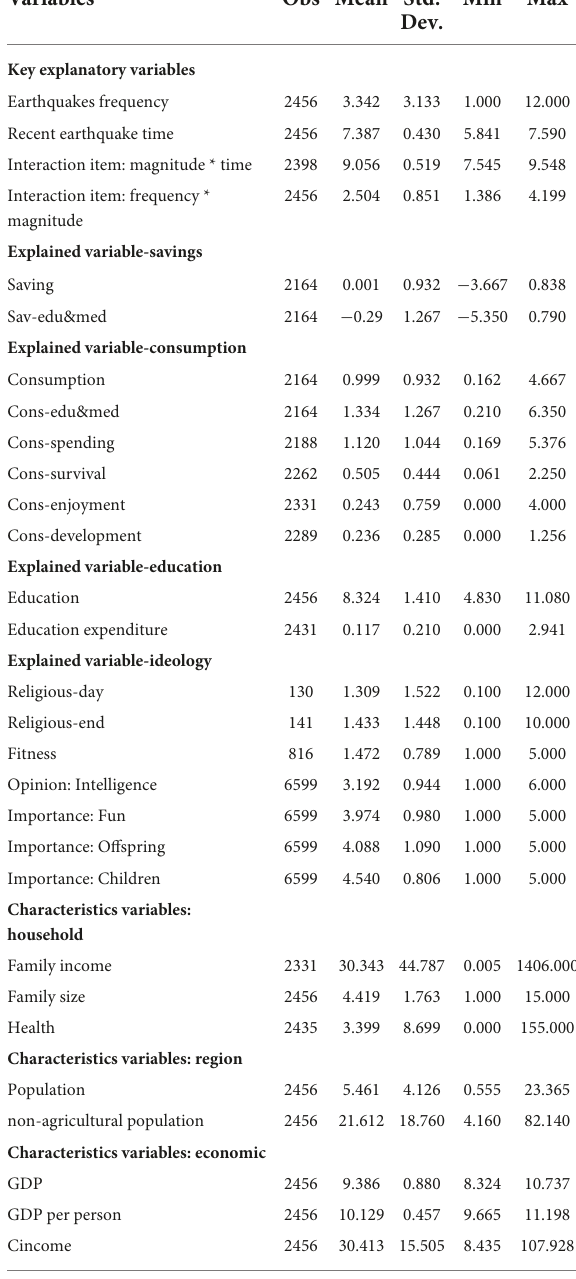
TABLE 1 Descriptive statistics of each